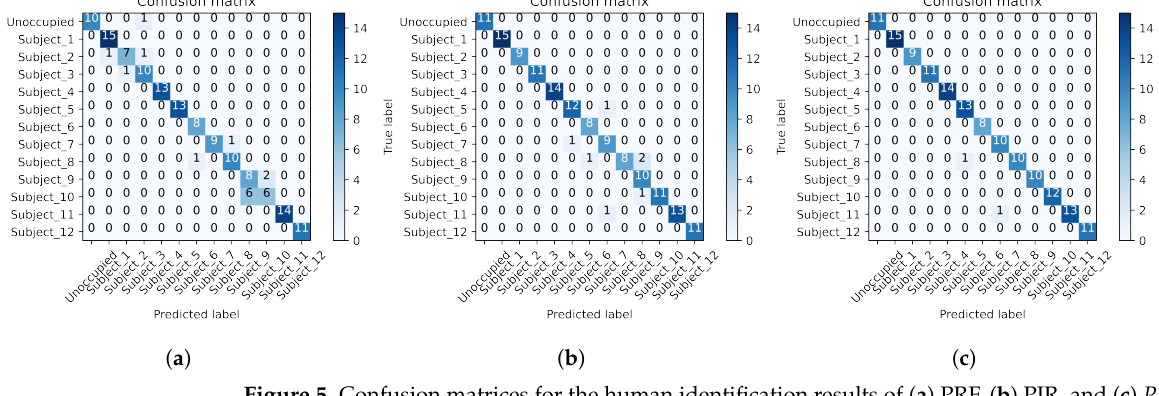
Figure 5. Confusion matrices for the human identification results of ( a ) PRF, ( b ) PIR, and ( c ) PRF-PIR sensor